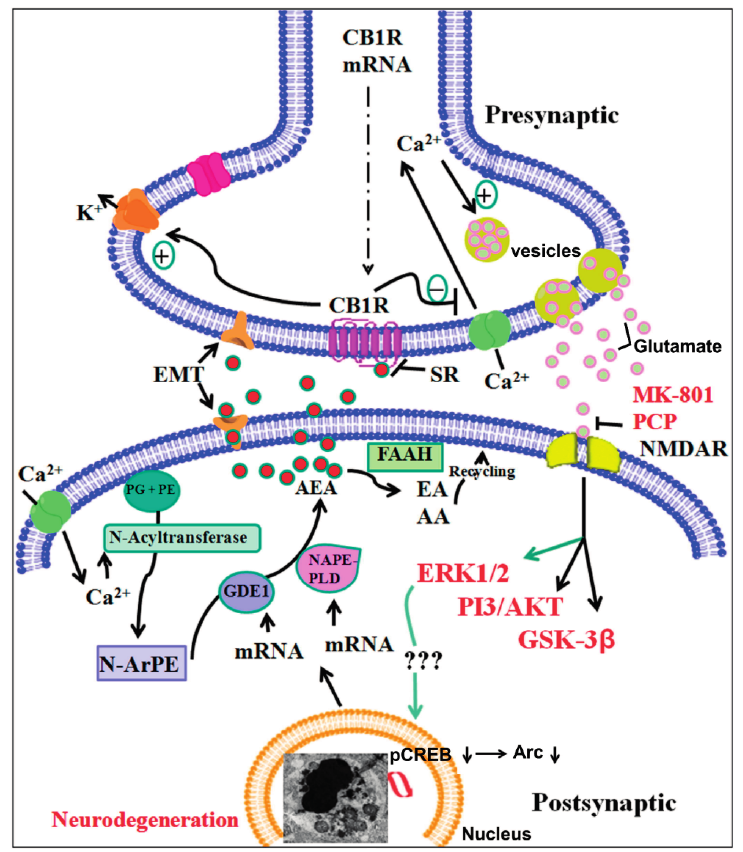
Figure 2. A proposed model suggesting that AEA/CB1R/ERK1/2/pCREB/Arc signaling regulates ethanol-induced neurodegeneration, resulting in neurobehavioral deficits in adult mice. P7 ethanol-enhances AEA levels (postsynaptic neuron) through transcriptional activation of NAPE-PLD and GDE1 enzymes. AEA acting through CB1Rs (AEA tone) (presynaptic neuron) may result in decreased glutamate release, which causes N -Methyl- D -aspartate (NMDA) receptor hypofunction, ERK1/2 and cAMP response element-binding